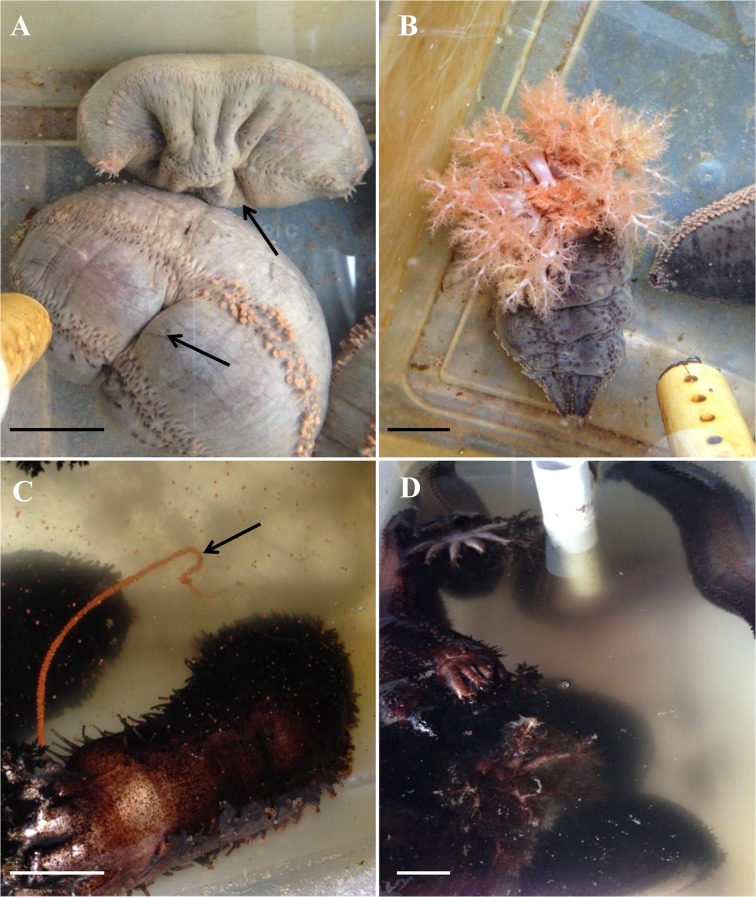
Minor side effects and normal behaviours recorded in tagged sea cucumbers.(A) Sea cucumbers tagged in the body wall showing ripples (arrows) around the implantation area immediately after tagging. (B) Large sea cucumbers tagged in the tentacles showed normal feeding, extending their tentacles fully and alternatively inserting them into the mouth. (C) A female sea cucumber tagged in the tentacles is releasing oocytes, visible as a reddish string (arrow), 40 days post tagging. (D) Water clouded with sperm in a tank holding sea cucumbers tagged in the body wall. Scale bars represent 3 cm.